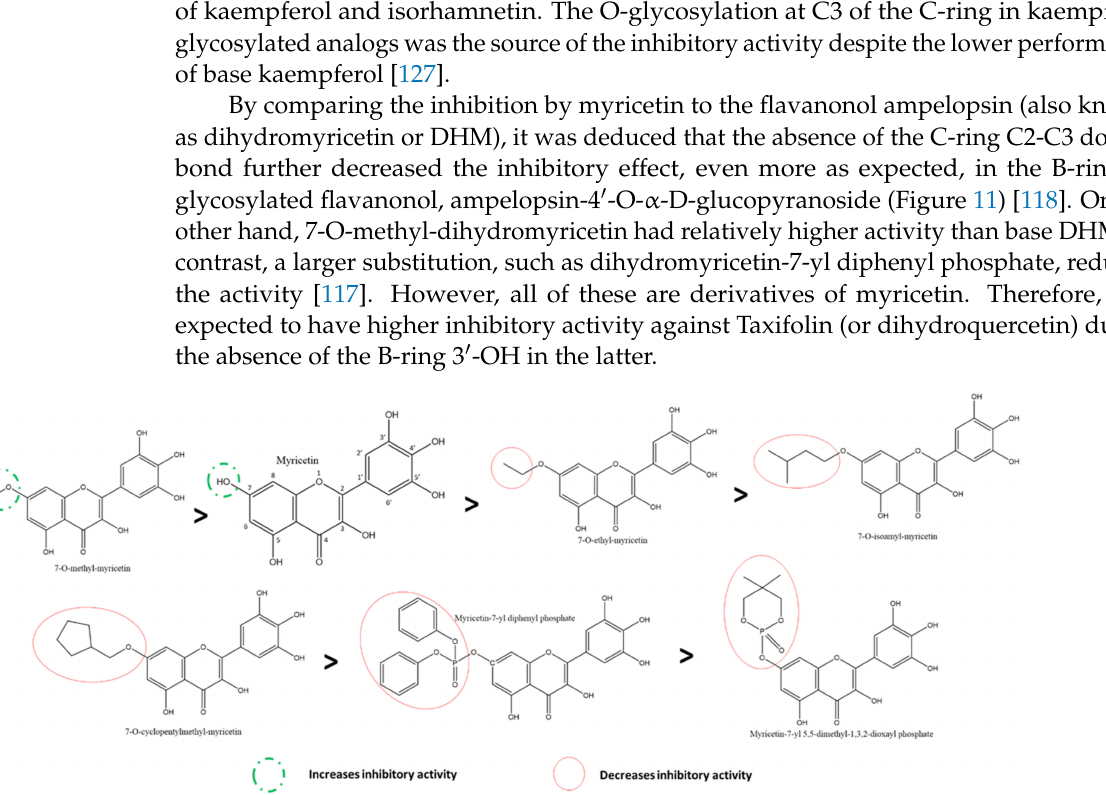
Figure 10. Structure–activity relationships of the flavonols myricetin and its analogs against SARS-CoV-2 3CLpro, adapted from the experiments of [117] using cell-based in vitro FRET assays. Substitutions and groups that result in increase/decrease in inhibitory activities are shown in red and green, respectively.